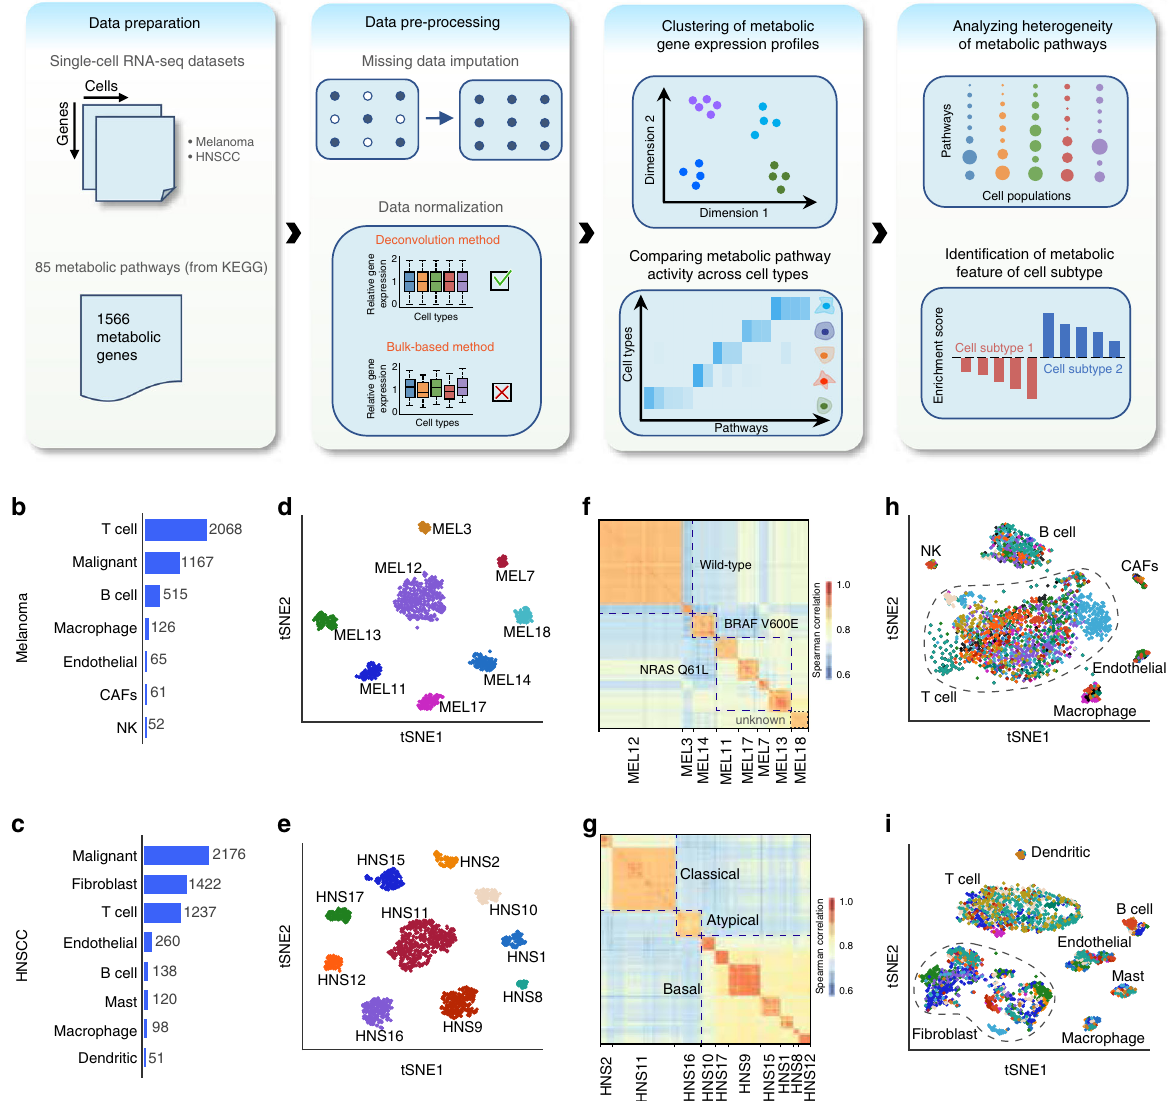
Fig. 1 Landscape of metabolic gene expression at single-cell level. a Schematic representation of the scRNA-seq data analysis pipeline. b Numbers of each type of cells in the melanoma dataset. c Numbers of each type of cells in the head and neck squamous cell carcinoma (HNSCC) dataset. d t-SNE plot of metabolic gene expression pro fi les of malignant cells from the melanoma dataset. The color of each dot indicates the tumor which the cell comes from. e Same as in d but for the HNSCC dataset. f Clustered correlation matrix showing Spearman ’ s rank correlation coef fi cients of metabolic gene expression pro fi les between malignant cells in the melanoma dataset. g Same as in f but for the HNSCC dataset. h t-SNE plot of metabolic gene expression pro fi les of non-malignant cells from the melanoma dataset. The color of each dot indicates the tumor which the cell comes from. i Same as in h but for the